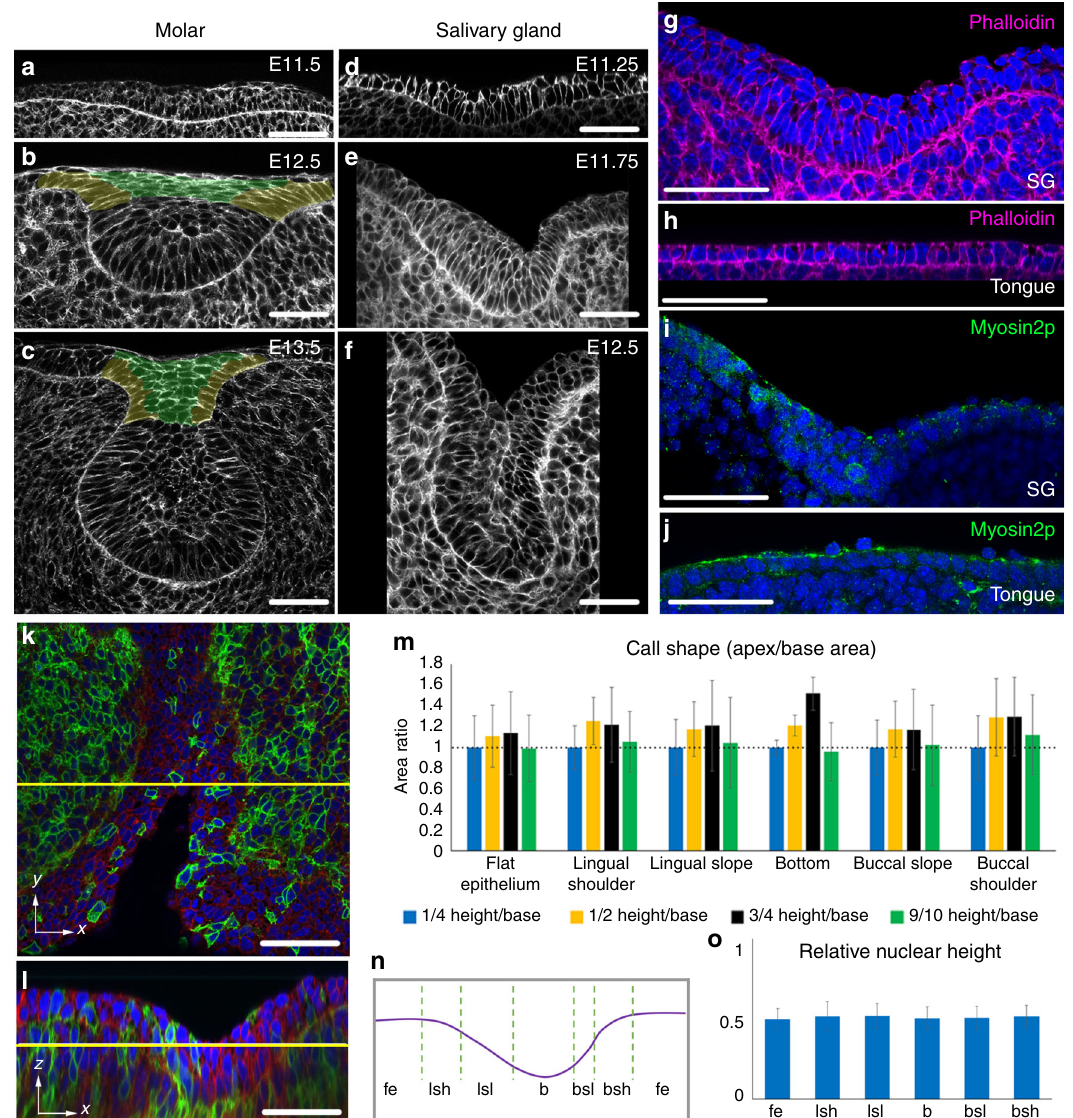
Fig. 1 Invagination of early salivary placode is not driven by cell wedging. a – f Phalloidin staining of indicated stages of molar tooth ( a – c ) and submandibular salivary gland ( d – f ). False-colouring indicates intercalating suprabasal cells (green) and shoulder/basal cells that transmit the contractile force to the basal lamina (yellow). g – j Phalloidin (magenta), DAPI (blue) staining of the SG placode ( g ), tongue epithelium ( h ), and phosho-Thr18/Ser19 Myosin 2 immuno fl uorescence (green) of the SG ( i ), and tongue epithelium ( j ). k , l Mosaically labelled mT/mG tissue stained by DAPI (blue) for cell shape and nuclear height analysis in SG. En face (k) and frontal (l) views. m Ratios of planar cross-sectional areas of cells at indicated heights to that at ¼ height in different regions of the SG invagination revealing no wedging (bars represent n = 25, 20, 100, 78, 48 and 14 cells in the respective regions in 11 placodes from 3 litters; p > 0.05 (one-way ANOVA)). n Schematic showing regions across a salivary placode mediolaterally used in M and O. Fe fl at epithelium, Lsh lingual shoulder region, Lsl lingual slope, B bottom, Bsl buccal slope, Bsh buccal shoulder. o Nuclear position (height above lamina) as fraction of total cell height in indicated regions (each bar represents 50 cells in 4 placodes from 3 litters; p > 0.05 (one-way ANOVA)). Scale bars in all panels: 50 μ m. Bar graphs are means ± SDs. Source data are provided as a Source Data fi